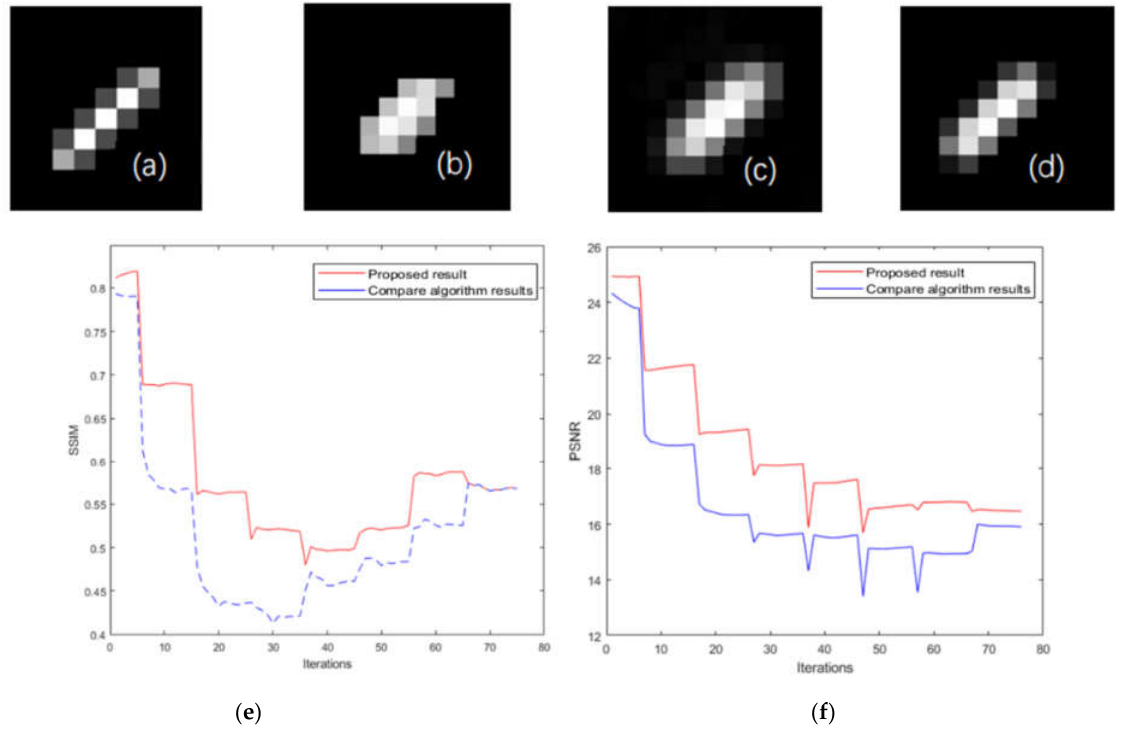
Figure 4. The kernel estimate result of ( a ) original kernel; ( b ) literature [11] algorithm result; ( c ) literature [24] algorithm result; ( d ) this paper; ( e ) normalized SSIM with [24]; ( f )normalized PSNR with [24]. Table 2. Kernel estimation quality evaluation table.